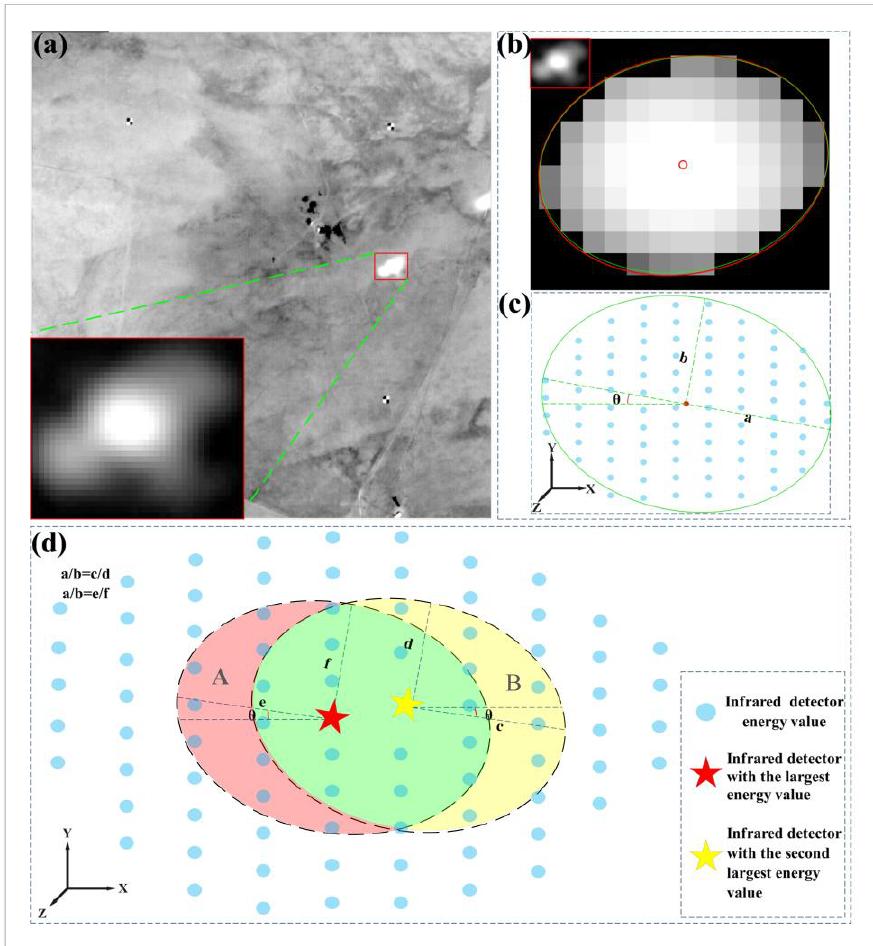
Figure 4. Basic schematic diagram. ( a ) The original footprint image; ( b ) The denoised footprint image; ( c ) The image abstracted from ( b ) based on the geometric relationship between footprint camera and infrared detectors; ( d ) The results of applying the geometric parameters in ( c ) to the spots captured by the detector. Among them, ellipses A and B were obtained by taking the largest and the second largest energy value captured by infrared detectors as the center and combining with the actual geometric parameters of footprints. The intersection of A and B forms green, red and yellow regions, representing the intersection of them, the difference between A and the intersection, and the difference between B and the intersection respectively.